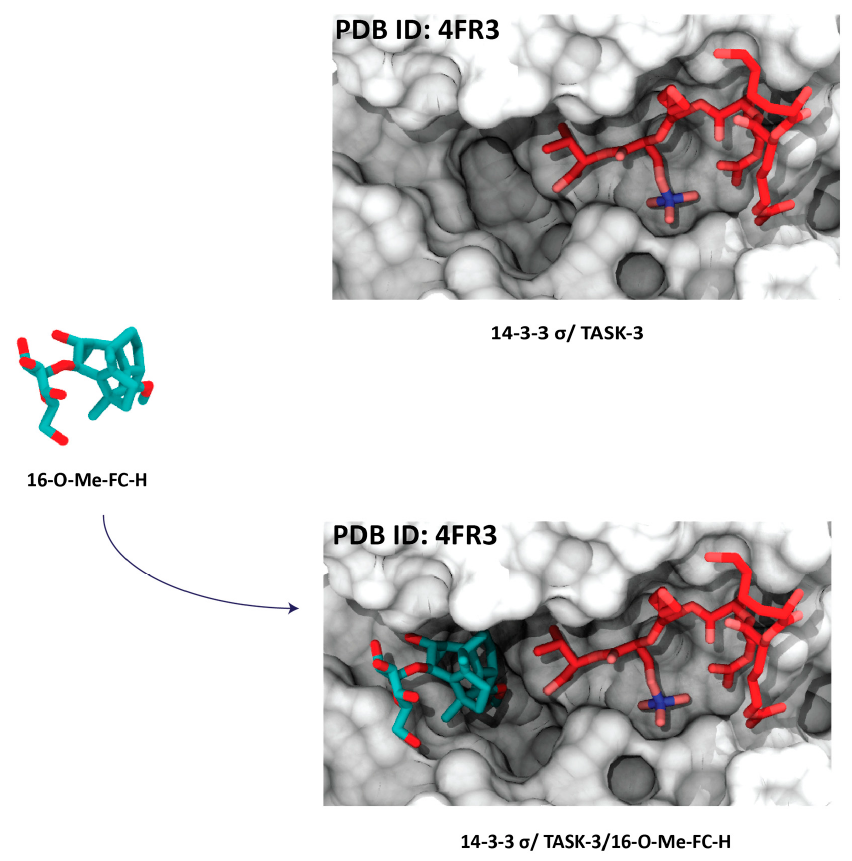
Figure 3. Example of a stabilizer that binds to the interface of 14-3-3 (white surface) and a peptide motif (red sticks) binding within the groove. When this peptide motif binds within the 14-3-3 groove, a druggable pocket is formed. A semisynthetic fusicoccin derivative (16-O-Me-FC-H) (cyan sticks) binds to this pocket and stabilizes the potassium channel subfamily K member 9 (TASK-3) and 14-3- 3 motif complex. The information was obtained analyzing the PDB entry 4FR3 [39].